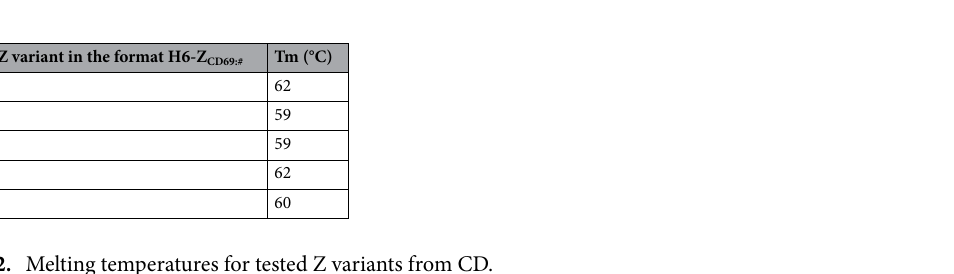
Table 2. Melting temperatures for tested Z variants from